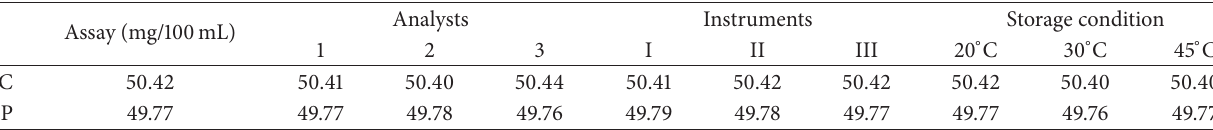
Table 5: Robustness study ∗∗